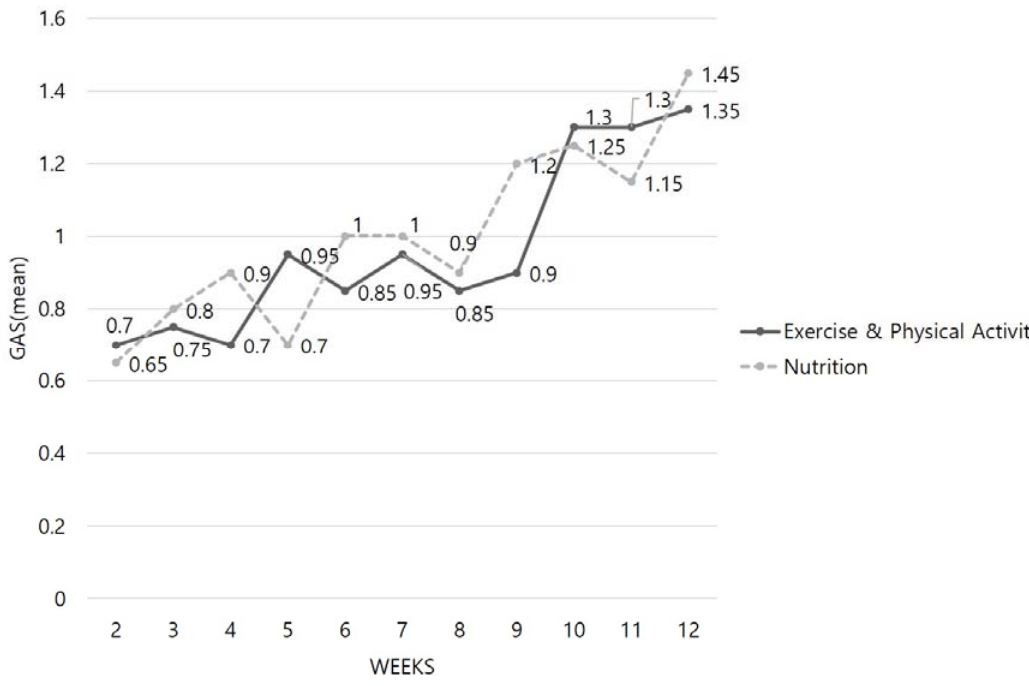
Figure 4. Changes in the average goal attainment scale in the intervention group over 12 weeks.